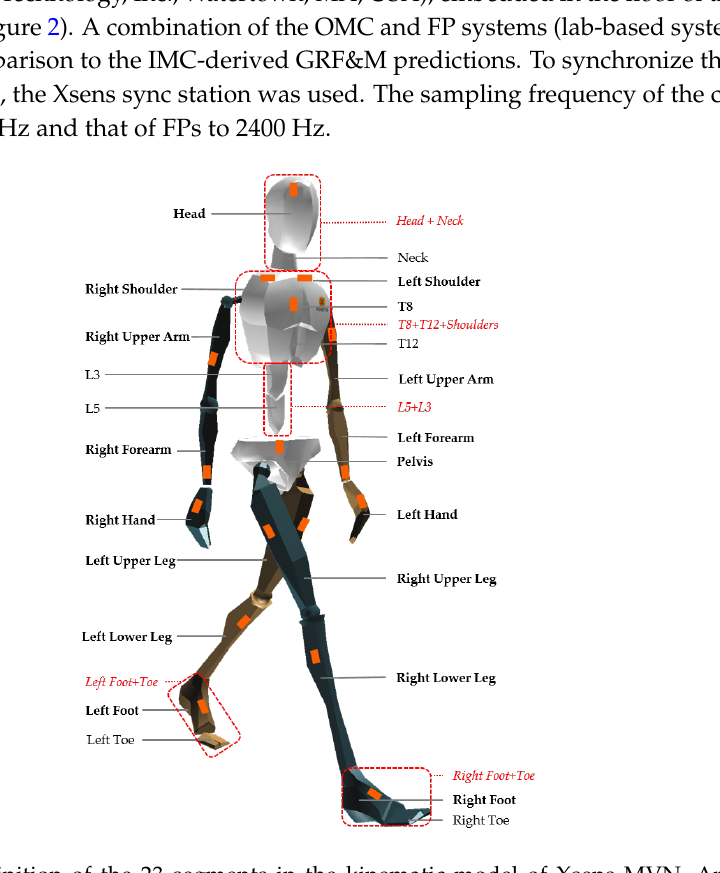
Figure 1. The definition of the 23 segments in the kinematic model of Xsens MVN. An inertial measurement unit is mounted on each of the 17 segments indicated with bold text. The 5 new segments (red italic font) are formed by the combination of MVN segments (within dashed-lined boxes) to match the segment definitions of De Leva